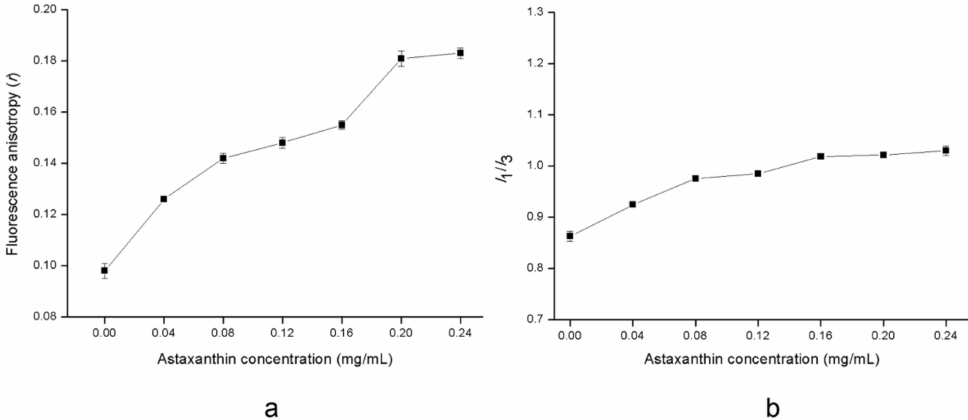
Figure 6. Change in fluorescence anisotropy ( r ) of 1,6-diphenyl-1,3,5-hexatriene (DPH) ( a ) and fluorescence peak intensity ratio of pyrene ( I 1 /I 3 ) ( b ) in membrane as a function of increasing the concentration of astaxanthin. Data are represented as the mean ± standard deviation ( n =